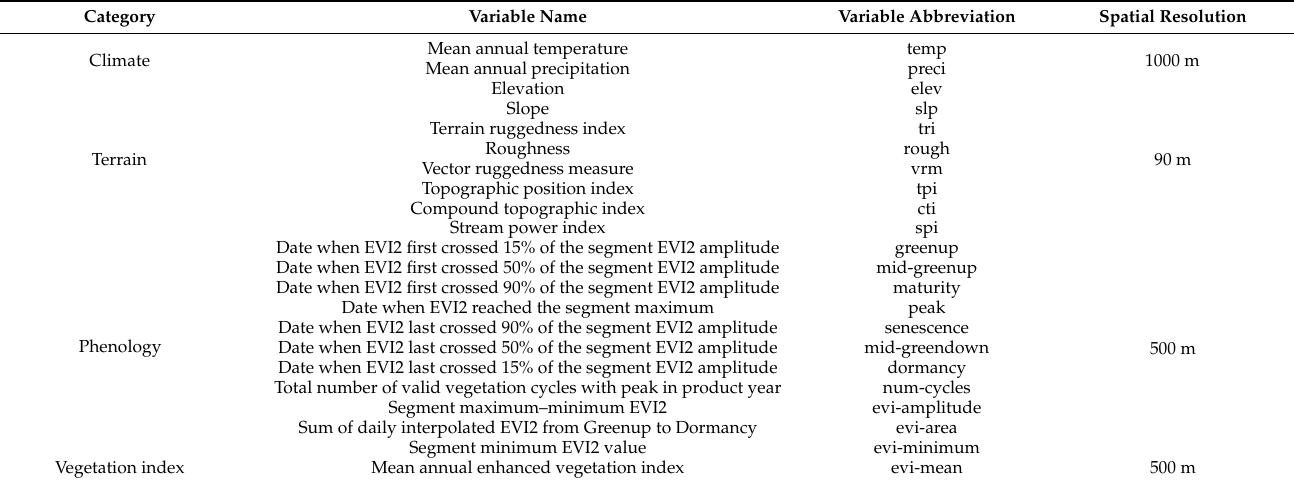
Table 1. Description of environmental covariates adopted in the study